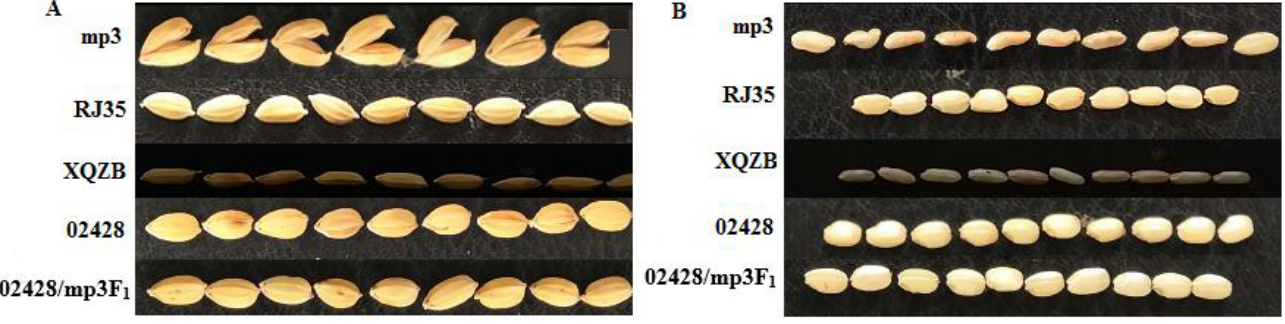
Figure 4. Grain shapes of mutant mp3 and wild-type rice. ( A ) Grain shapes of mutant mp3 and wild-type rice. ( B ) Brown rice of mutant mp3 and wild-type rice. Table 2. Grain shape of mutant mp3 and wild-type rice.